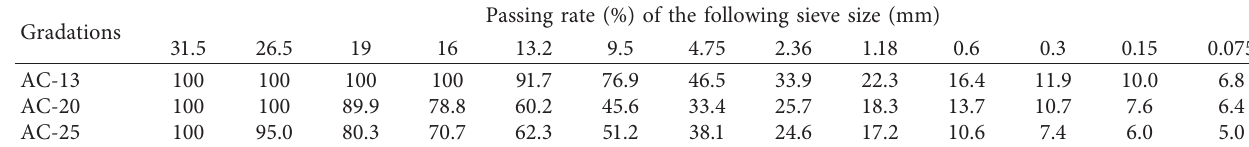
Table 5: Aggregate gradations of different asphalt